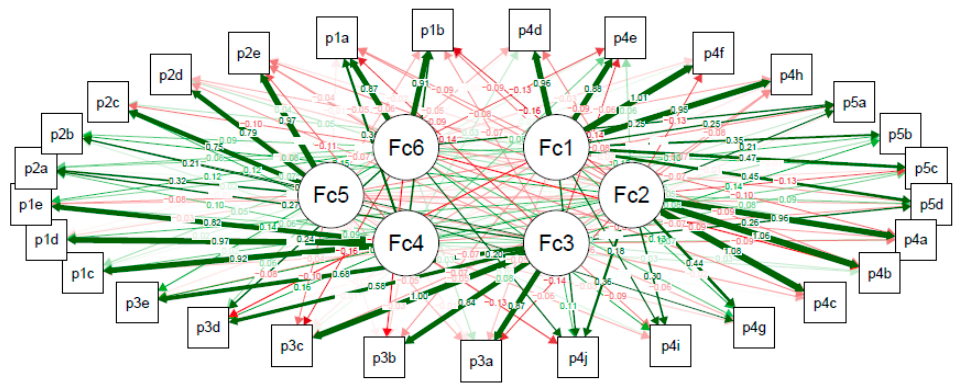
Figure 2. Exploratory factor analysis of the different subscales of the Diabetes Foot Ulcer Scale-Short Form (DFS-SF). Fc1–Fc6, Factor 1 to Factor 6 of the exploratory factor analysis. p1a–p5d are the items